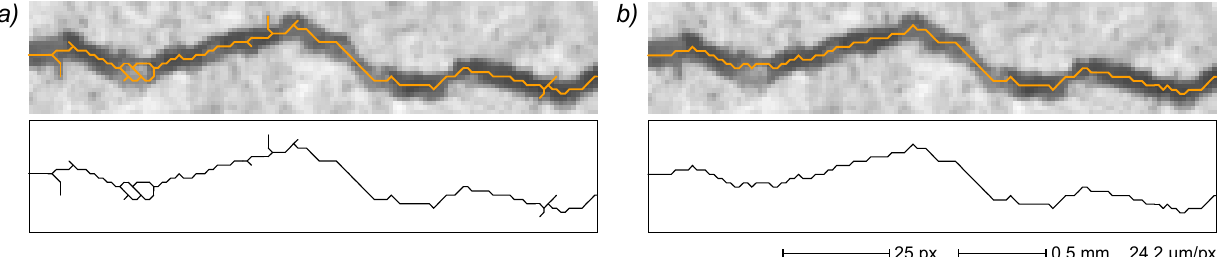
Figure 9. Artefact removal. The EG of a relatively thick crack demonstrates small branches and cycle artefacts derived from the skeletonization process ( a ). A removal algorithm based on shortest path search effectively removes all artefacts leaving the main crack path only ( b ). Top: original image with superimposed EG; bottom: EG alone.